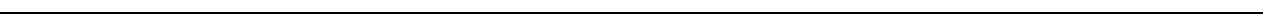
Fig. 5 Drugs falling into Class IV are synergistic with drugs targeting the PI3K pathway. a , b GR values for individual drug combinations a or over a range of combinations b and excess over Bliss scores (bottom) for 72 h exposure of BT-20 cells to combinations of the PI3K inhibitor alpelisib with either the ErbB inhibitors lapatinib (left) or neratinib (middle) or with the MEK inhibitor trametinib (right). Histograms in a show the mean of three biological repeats and error bars indicate the standard error of the mean; p-value is based on a t-test. Heatmaps in b show data from one out of three biological replicates. c Network of signi fi cant perturbations (SCS > 1.3) for BT-20 cells. Each node is a unique perturbation (combination of drug, time point, and concentration) and edges are drawn between perturbations with a cosine distance in the lower 5-percentile. Nodes are colored by drugs targeting receptors, the MAPK proteins or components of the PI3K/AKT pathways (left) or the GR value of the response (right). Node size re fl ects drug concentration. d Schematic of the converging effect of drug treatments and illustration of drug equivalence classes in